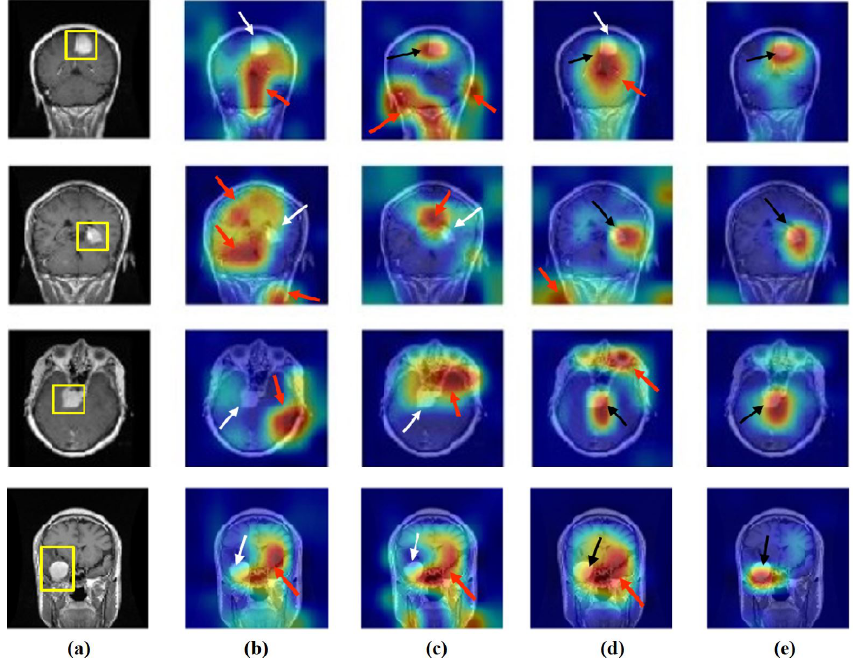
Figure 17. Visualisation of deep features for class meningioma of brain tumour test set images obtained by each model: ( a ) original image, ( b ) ResNet-50 pre-trained network, ( c ) DeTraC, ( d ) 4S-DT , and ( e ) XDecompo